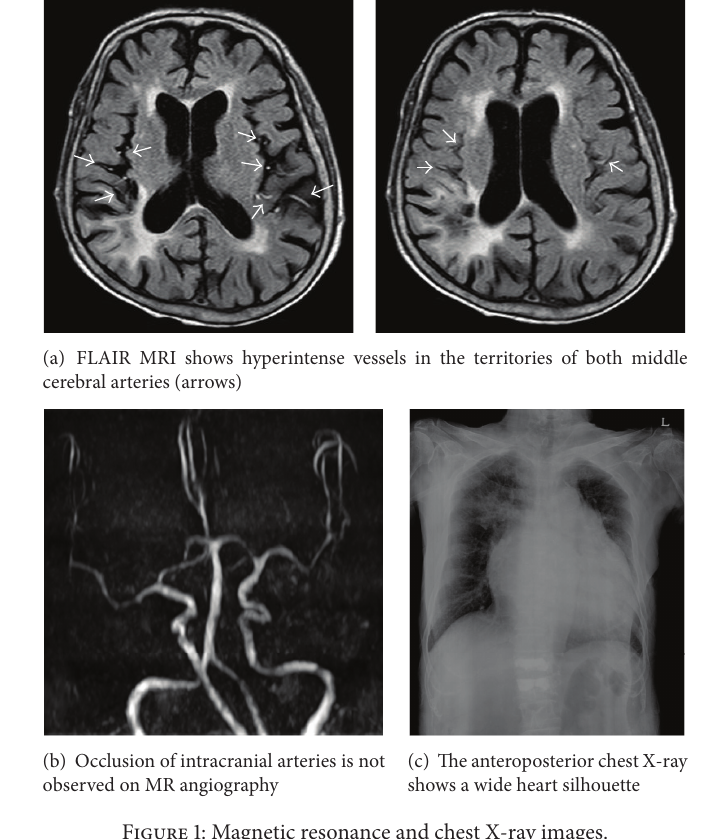
Figure 1: Magnetic resonance and chest X-ray